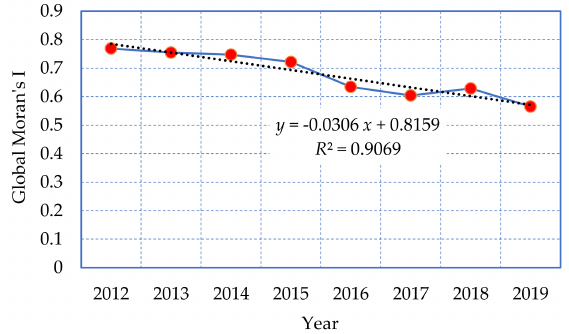
Figure 9. Global Moran’s I of poverty probability from 2012 to 2019 in Guizhou Province.